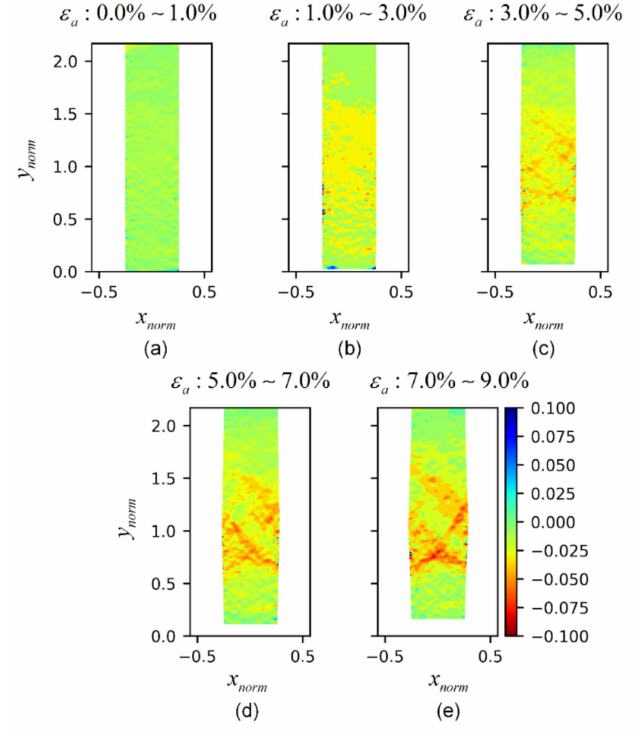
Figure 24. Evolution of gradient along ˆ y axis F 33 of test 121304b: ( a ) axial strain 0.0%–1.0%; ( b ) axial strain 1.0%–3.0%; ( c ) axial strain 3.0%–5.0%; ( d ) axial strain 5.0%–7.0%; ( e ) axial strain